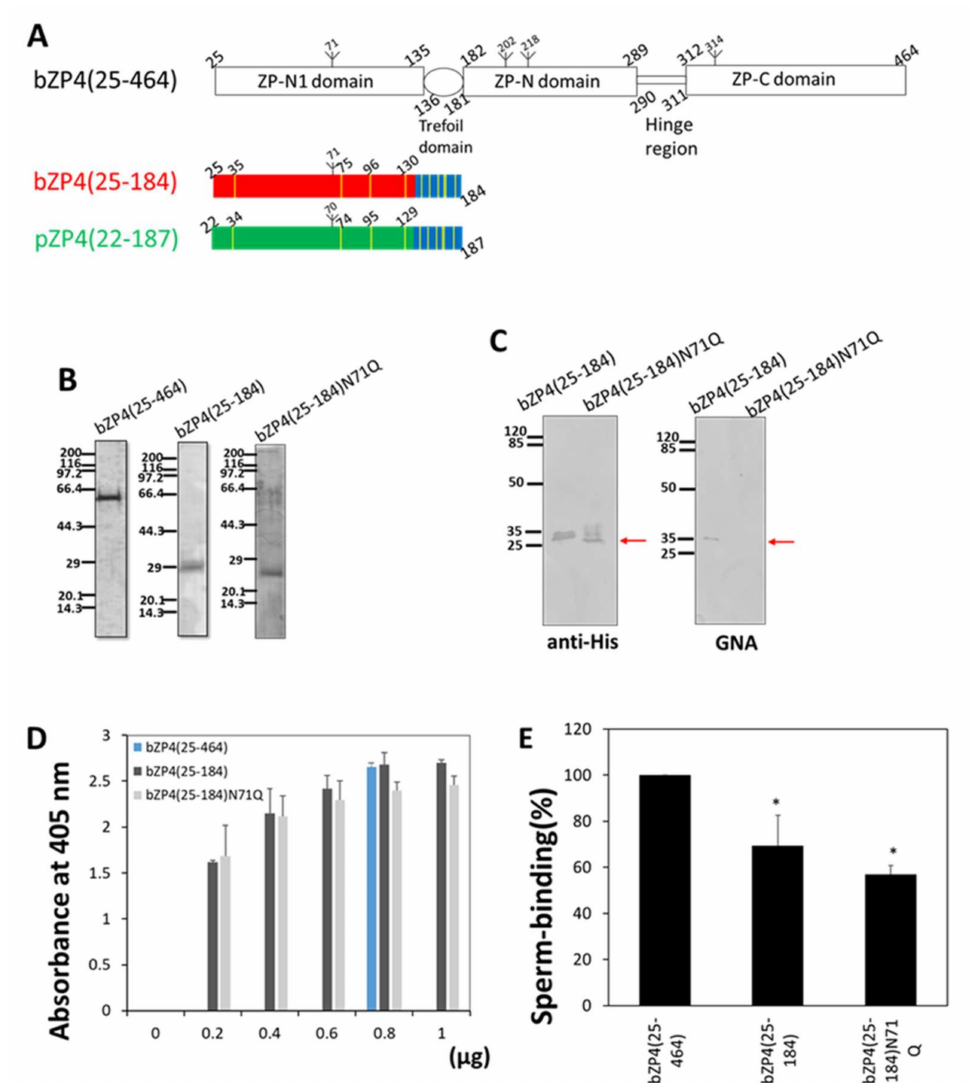
Figure 1. Effect of N-glycosylation site mutation of the N-terminal domain of bovine ZP4 on the sperm-binding activity of the domain. ( A ) Domain architecture of mature bovine (b)ZP4(25–464) polypeptide, and a schematic representation of the truncated bZP4(25–184) consisting of the ZP-N1 domain (red) and trefoil domain (blue) and its corresponding porcine (p)ZP4(22–187) (ZP-N1 domain, green; trefoil domain, blue) counterpart examined in this study. Inverted tripods mark potential N-glycosylation sites, and cysteine residues are highlighted in yellow bars in bZP4(25–184) and pZP4(22–187). ( B ) Sodium dodecyl sulphate polyacrylamide gel electrophoresis (SDS-PAGE) analysis of the bZP4(25–464), bZP4(25–184) and N-glycosylation site mutant, bZP4(25–184) N71Q. These proteins were expressed in Sf9 cells and purified by TALON resin specific to His-tag. The SDS-PAGE gels were silver-stained. Molecular mass standards (kDa) are indicated on the left side of each gel. ( C ) Western blot analyses of bZP4(25–184) and bZP4(25–184) N71Q. Both proteins were detected by immunoblotting with anti-His antibody (anti-His), while only bZP4(25–184) was detected by Galanthus nivalis agglutinin (GNA). The objective bands are indicated by arrows. Molecular mass standards (kDa) are indicated on the left side of each panel. ( D ) Adsorption of bZP4(25–184) and bZP4(25–184) N71Q to plastic wells. The amount of protein necessary for adsorption saturation